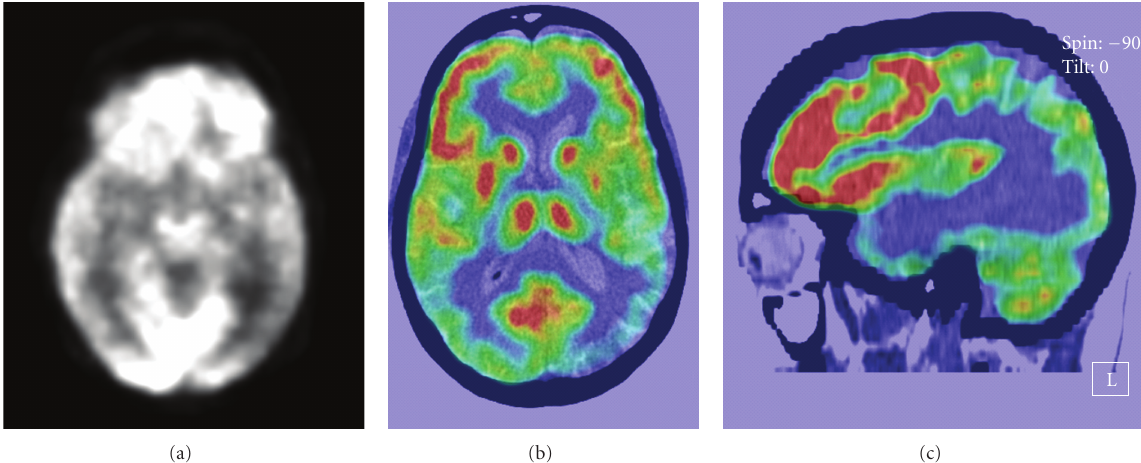
Figure 1: (a)–(c) show brain PET scan of the patient showing bilateral, predominantly left-sided, parietotemporal hypometabolism in di ff erent